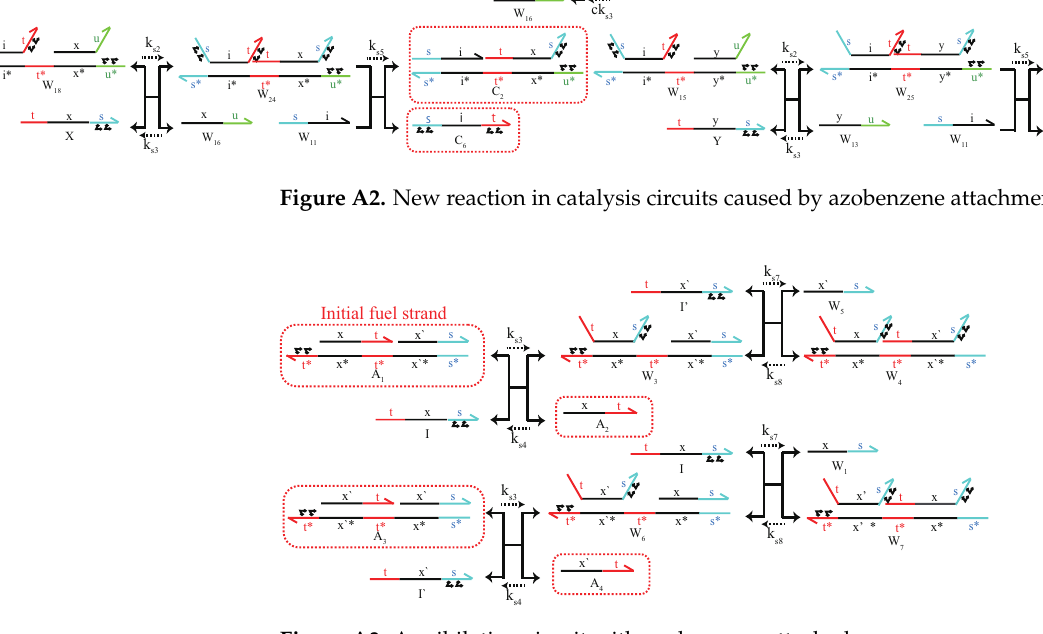
Figure A3. Annihilation circuit with azobenzene